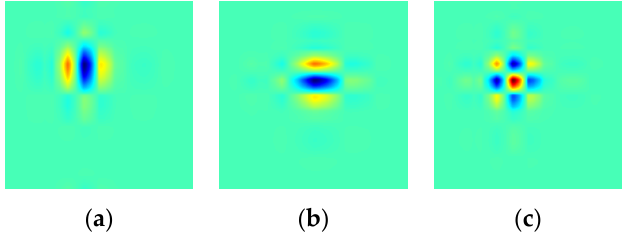
Figure 3. Directional Selectivity of discrete wavelet transform (DWT). ( L = Low, H = High). ( a ) LH; ( b ) HL; ( c ) HH.